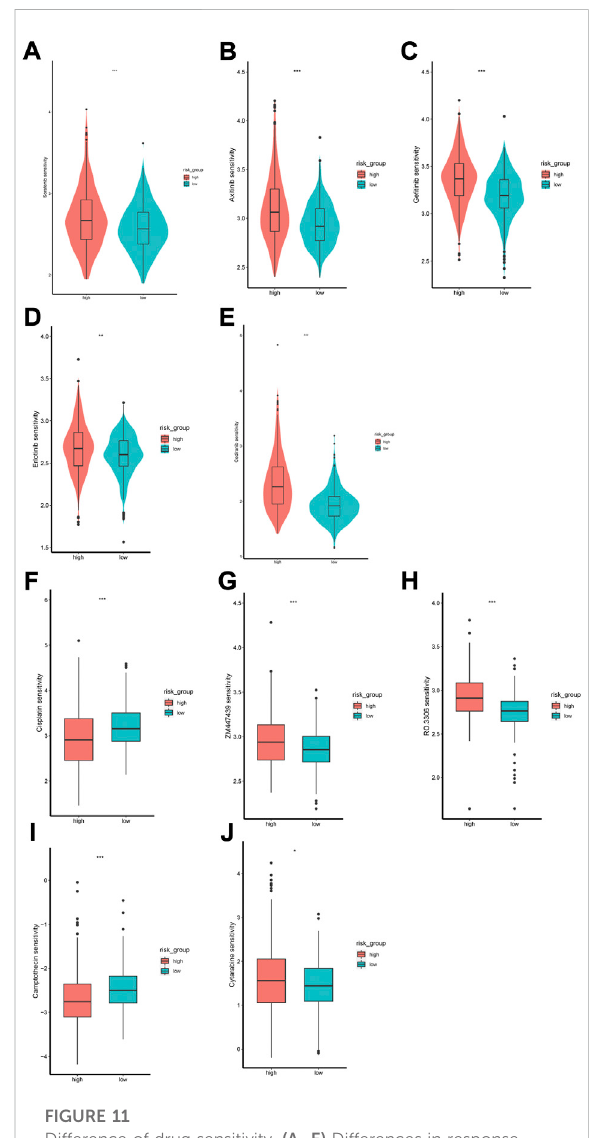
FIGURE 11 Difference of drug sensitivity. (A – E) Differences in